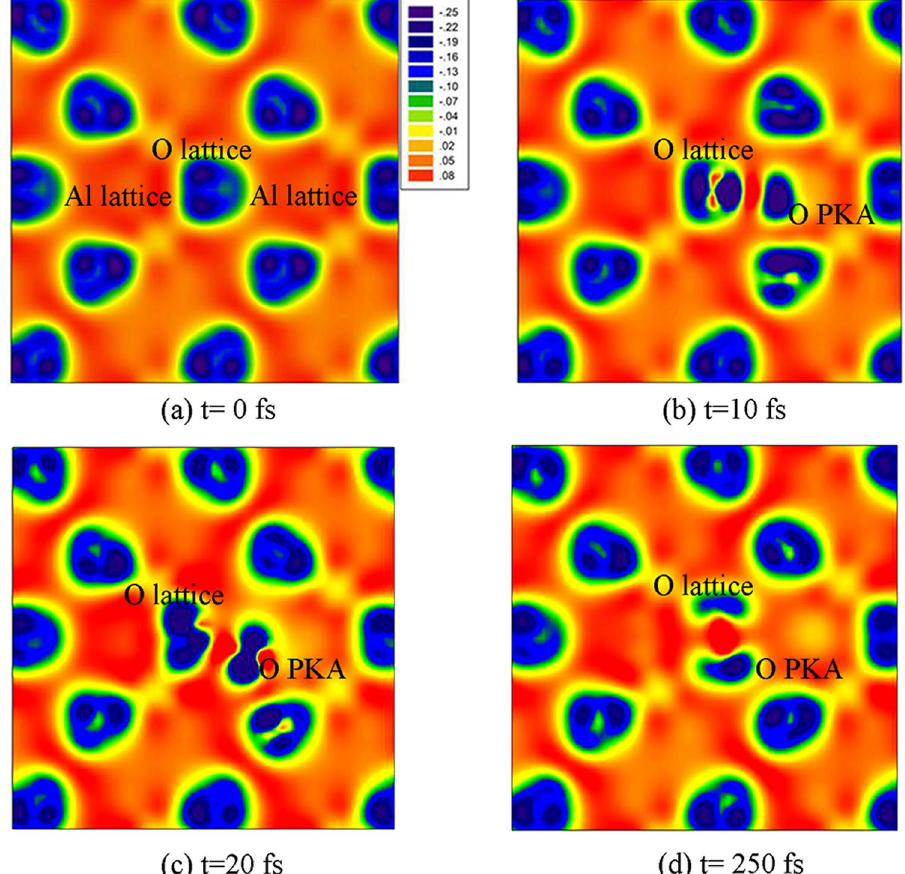
Figure 2. Charge-density contours projected onto plane during O [2110] recoil events at energy of 27